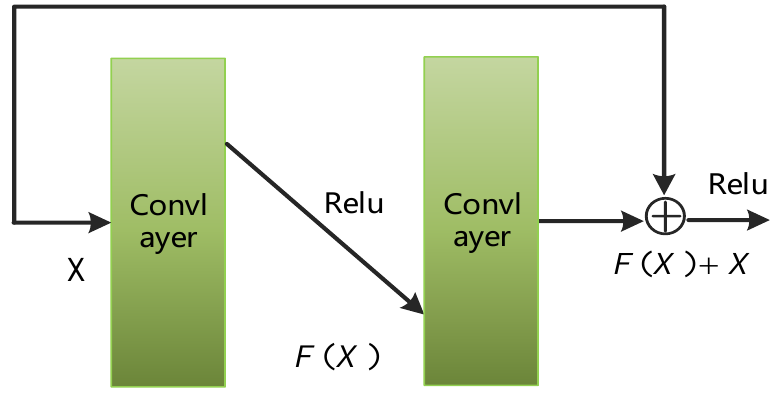
Figure 10. ResNet18 residual